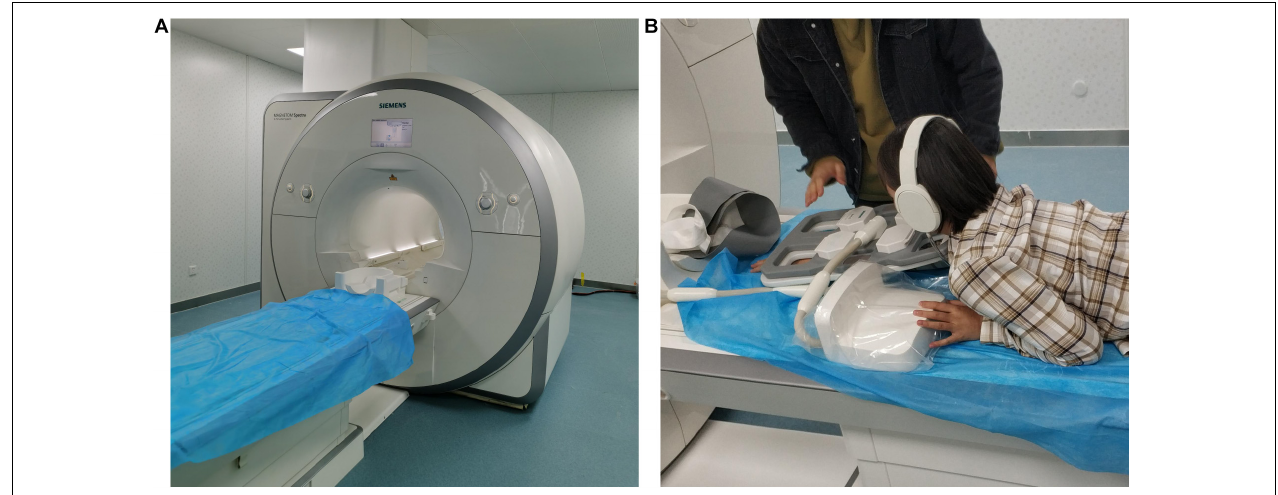
FIGURE 3 | Schematic diagram of human upper limb information collection: (A) Siemens MAGNETOM spectra and (B) scanned images of a female volunteer.